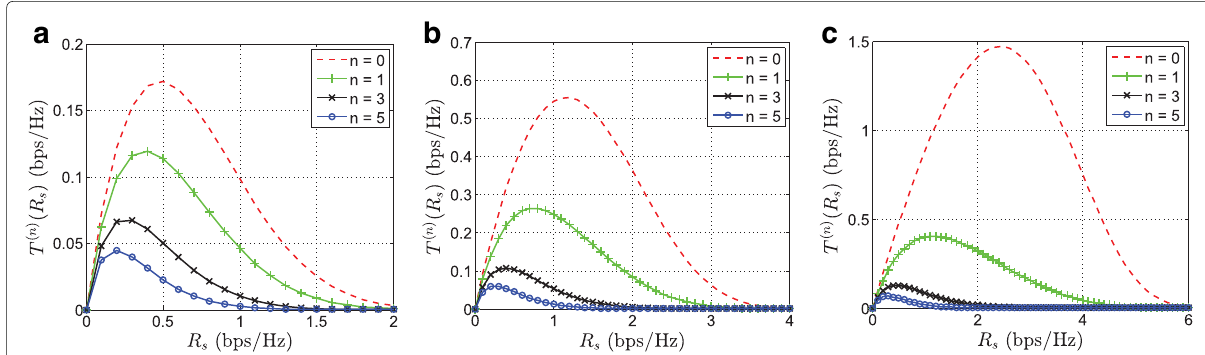
Fig. 2 Relationship between effective secrecy throughput T ( n ) ( R s ) and R s with different n on basis of β = 1. a SNR = − 3 dB. b SNR = 3 dB. c SNR = 10